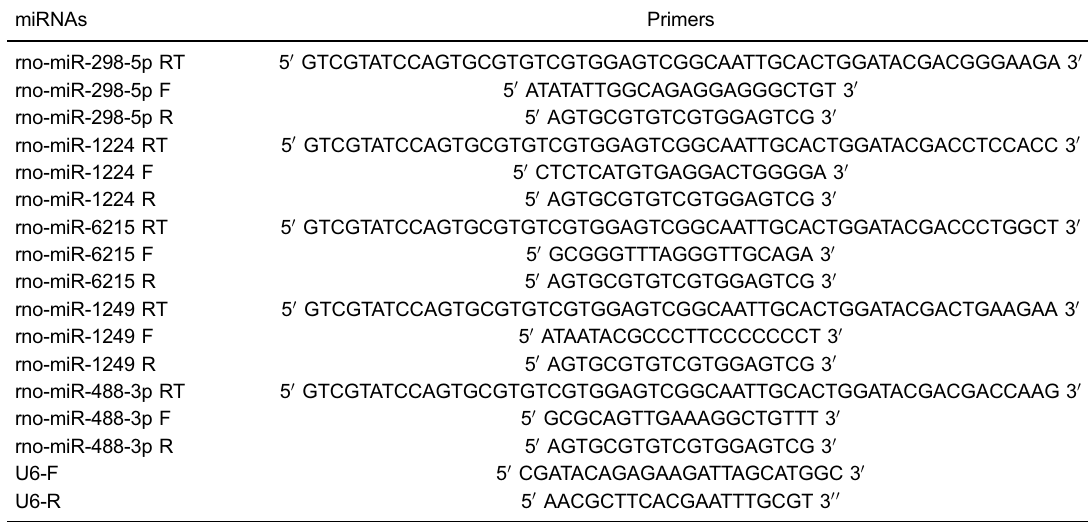
Table 1. Primer sequence of real time PCR.